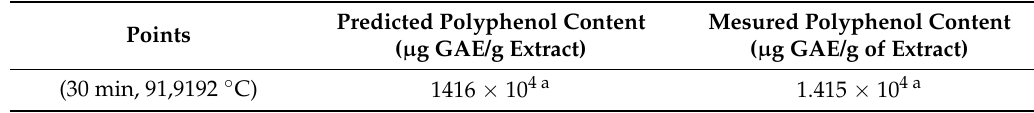
Table 3. Confirmation results of the model with the measured values and the predicted values of the studied responses.